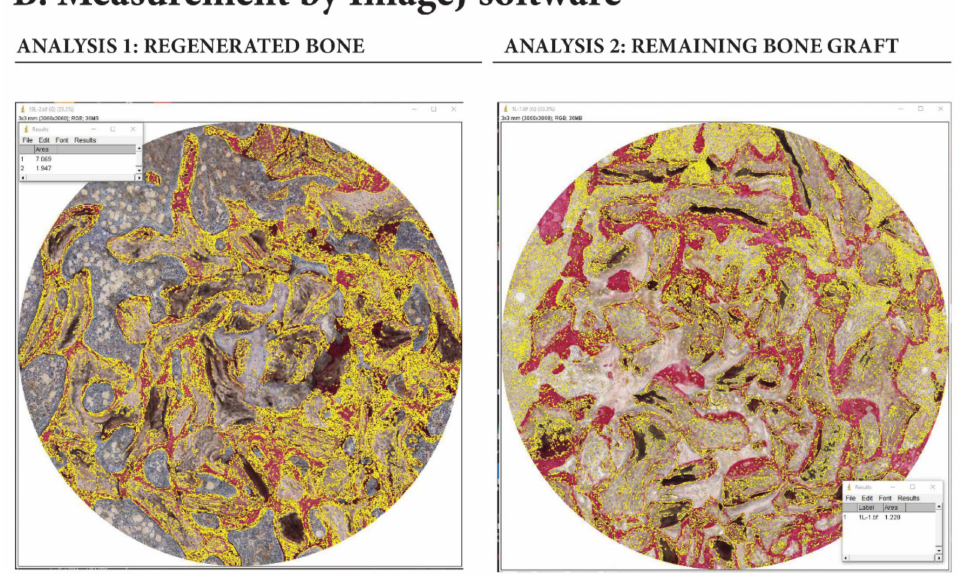
Figure 3. In the histological sections: ( A ) a 3-mm region of interest (ROI) was identified; and ( B ) quantitative measurements were then made to assess new bone formation (N-BF%), remaining bone graft (RBG%), and trabecular bone space (Tb.Sp%) using ImageJ